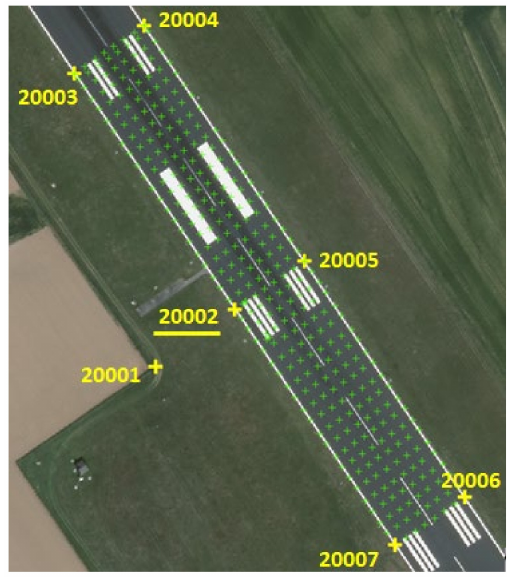
Figure 10. The basic geodetic grid (yellow crosses) and measured perpendicular grid (green